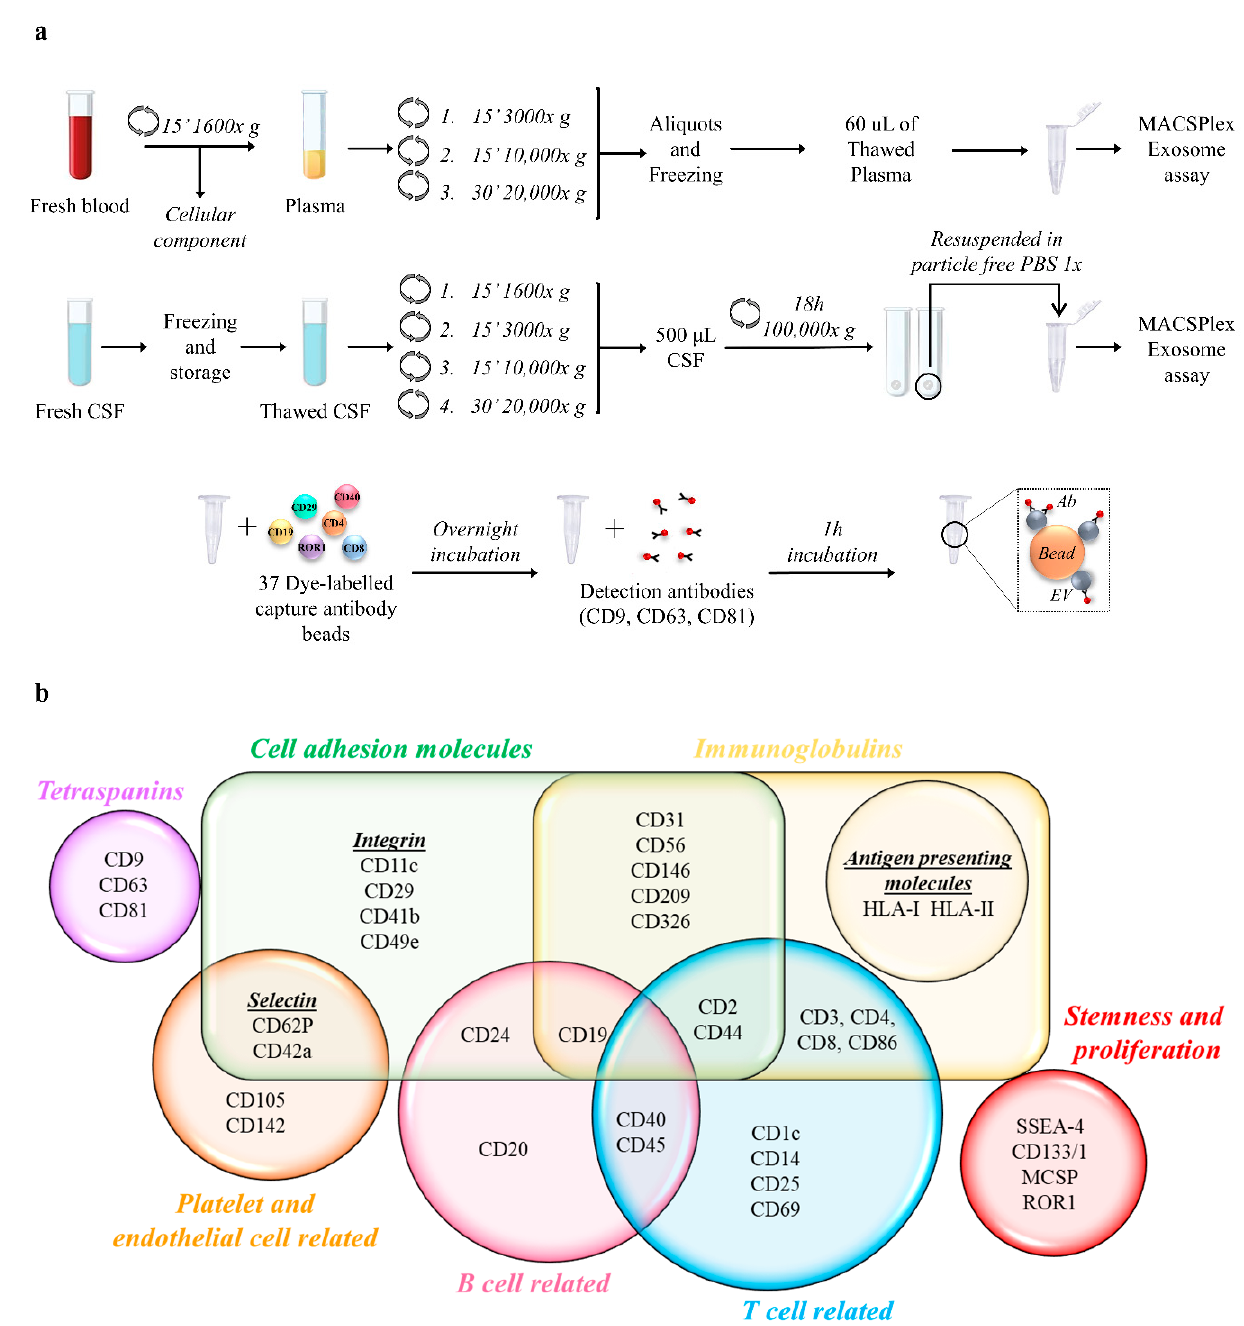
Figure 1. Plasma and CSF preparation for MACSPlex human Exosome assay. ( a ) Protocol for extracellular vesicle (EV) enrichment and characterization by MACSPlex Exosome Assay. Blood and cerebrospinal fluid (CSF) underwent serial centrifugation to eliminate cellular components and larger EVs. Samples were incubated overnight with phycoerythrin (PE)- and fluorescein isothiocyanate (FITC)-labeled capture beads, coated with antibodies against 37 different EV surface markers. APC-conjugated detection antibodies against CD9, CD63, and CD81 were added and incubated for 1 h. After washing steps, samples were analyzed by flow cytometry. ( b ) Schematic representation of the 37 EV surface markers analyzed by MACSPlex human Exosome assay.